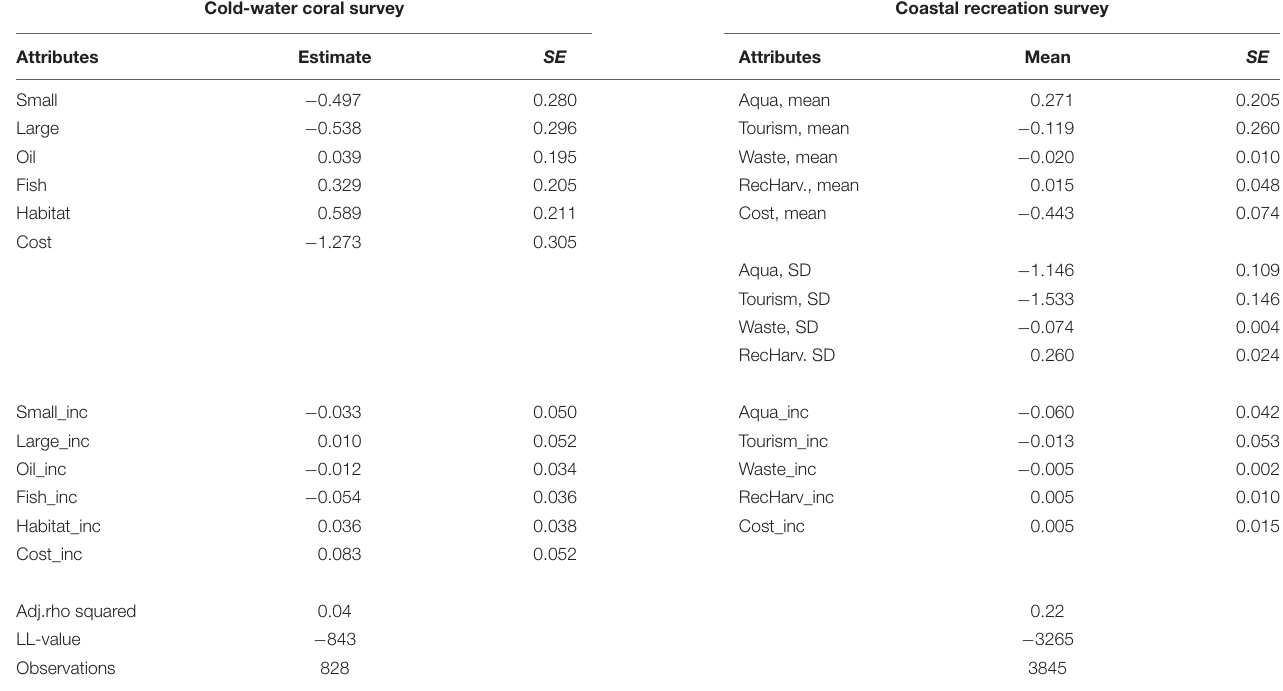
TABLE A7 | Results for model with socio-demographic interaction for income. Cold-water coral